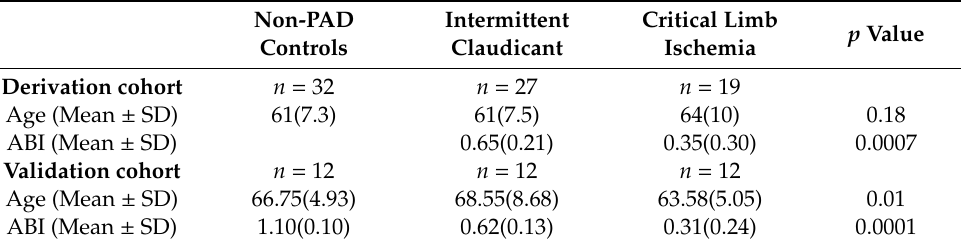
Table 1. Patient